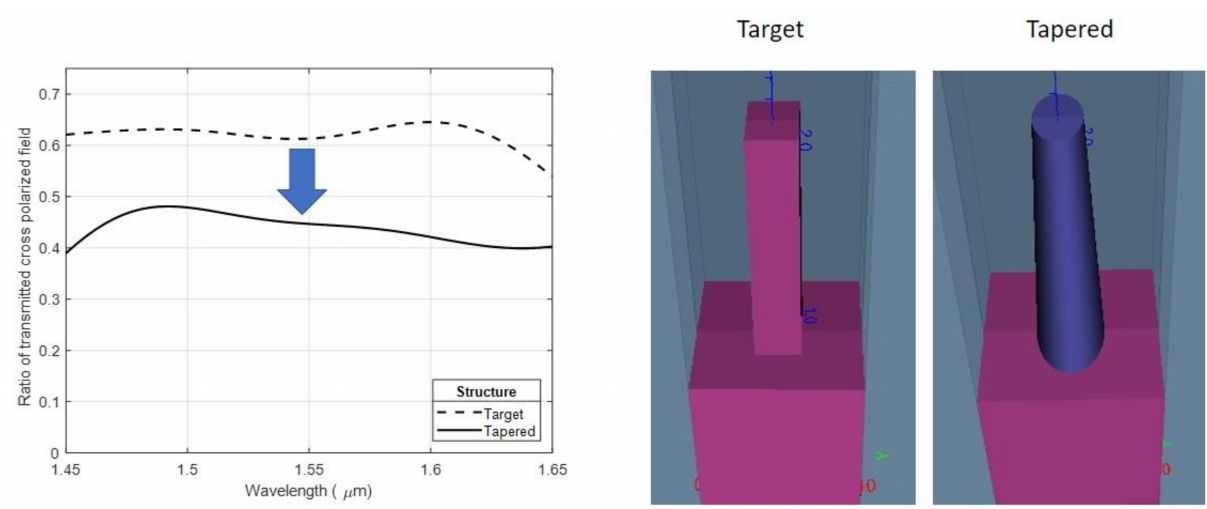
Figure 12. Plots of simulation curves considering the cases in which the patterns present straight (target) or tapered